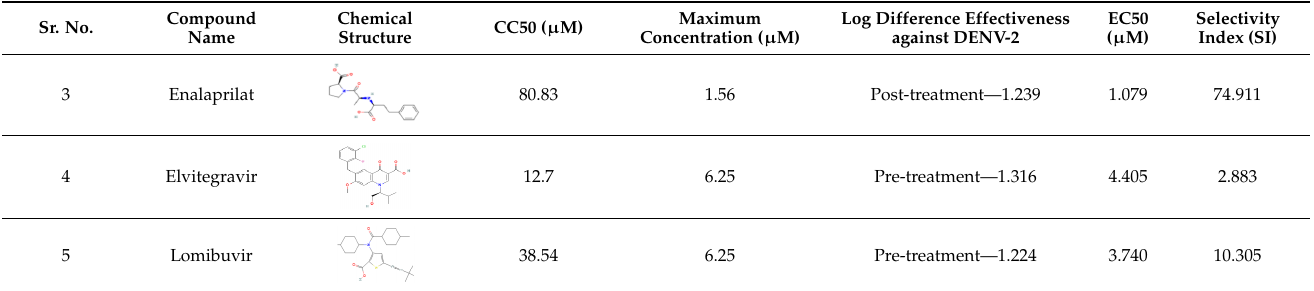
Table 2. Summary of effective inhibition under different treatment conditions.